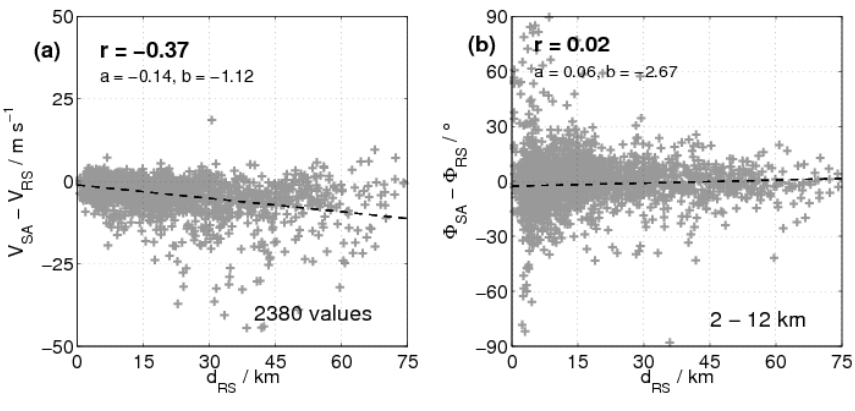
Fig. 2. Scatter plots (SA wind minus radiosonde wind measurements) of wind speed (a) and wind direction (b) between 2 and 12km depending on the distance between radiosonde and radar for all radiosonde launches in 2004–2007.